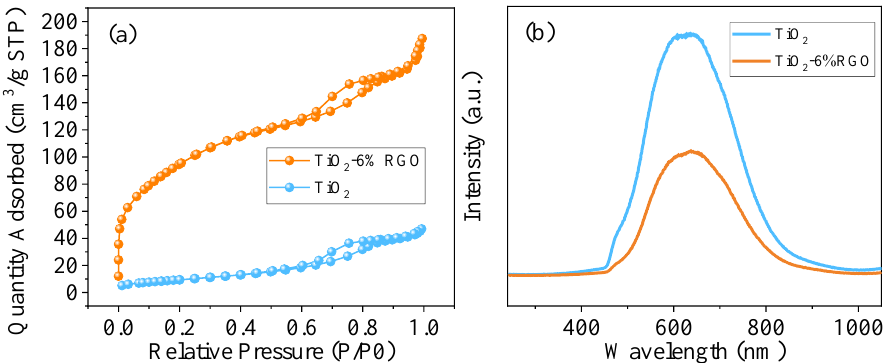
Figure 5. ( a ) Nitrogen adsorption – desorption isotherm of TiO 2 and TiO 2 -6%RGO, ( b ) PL spectra of TiO 2 andTiO 2 -6%RGO. Table 2. The BET surface area and pore volume of TiO 2 and TiO 2 -6%RGO.